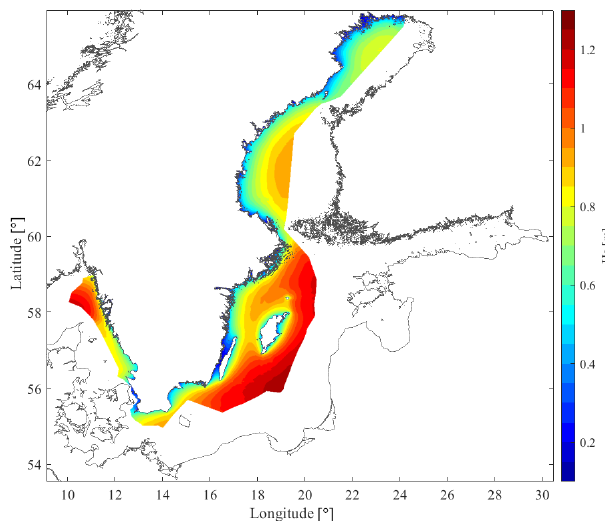
Figure 10. Ice-free average significant wave height, H s , in the SEEZ from a 16-year high-resolution model simulation from the SWERM project with methods described in Strömstedt et al. (2017) and Nilsson et al.